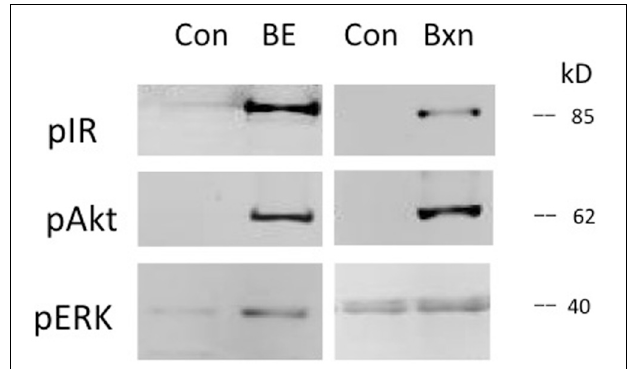
FIGURE 4 | Effects of Bombyx bombyxin II on ecdysone secretion. Prothoracic glands from day 3 fifth instar larvae were incubated for 4 or 8h in medium containing no hormone (Control) or Bombyx bombyxin II (160nM) ( n = 6 and 11 glands per group, respectively). In separate experiments, glands were incubated for 4h in no hormone or 160nM bombyxin, and then challenged for 90min in medium with no hormone, bombyxin, PTTH (7nM) or PTTH + bombyxin ( n = 16 glands per group). Culture medium was assayed for ecdysone by radioimmunoassay. None of the bombyxin-treated groups differed from their respective controls (ANOVA, Tukey–Kramer post-hoc test, p > 0.05).